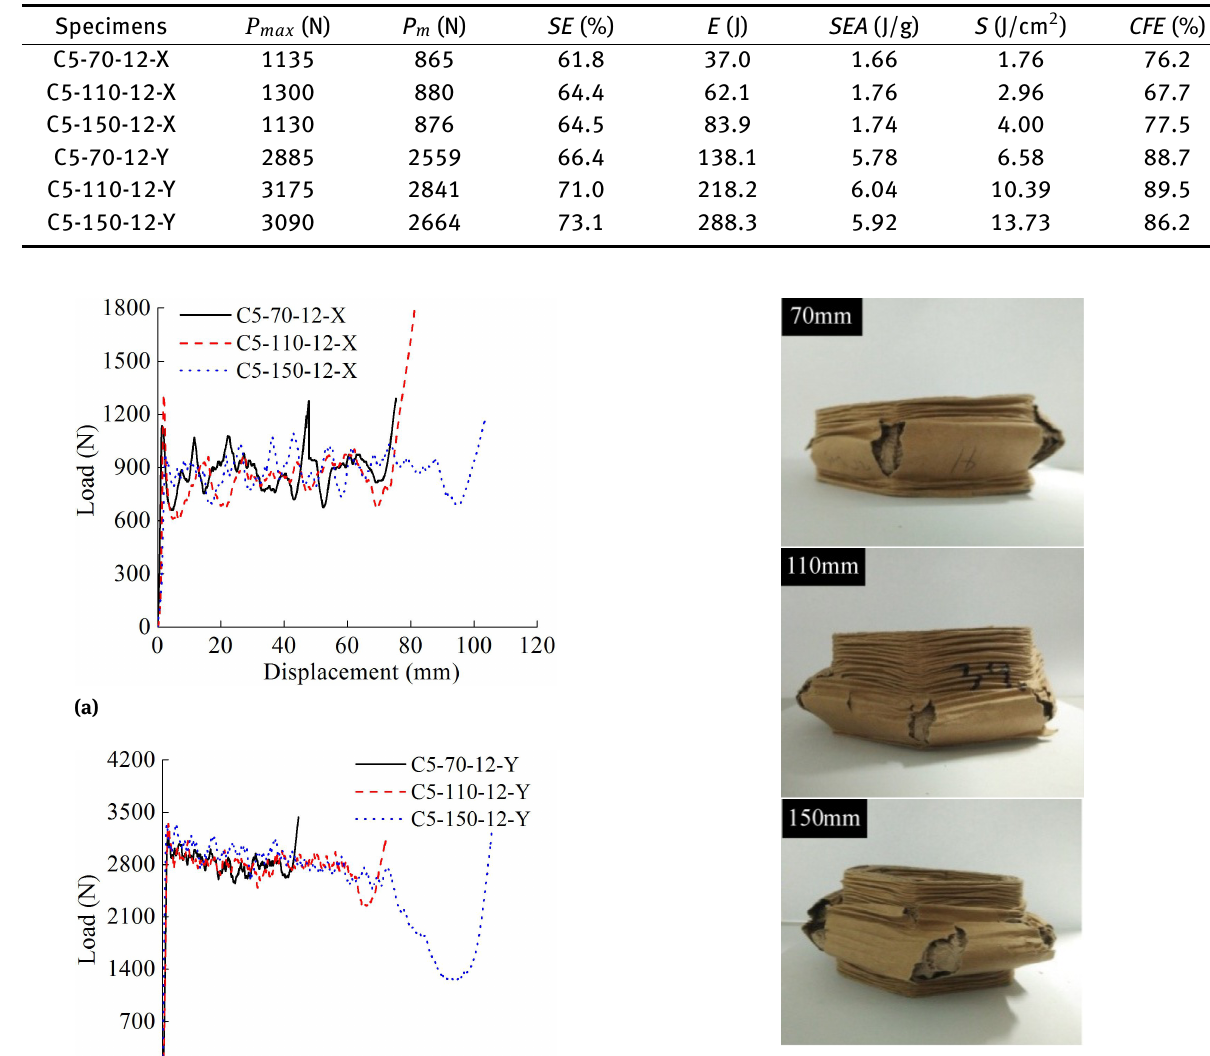
Figure 14: Crush deformation of regular pentagon paper corrugation tubes along Y direction with different tube lengths